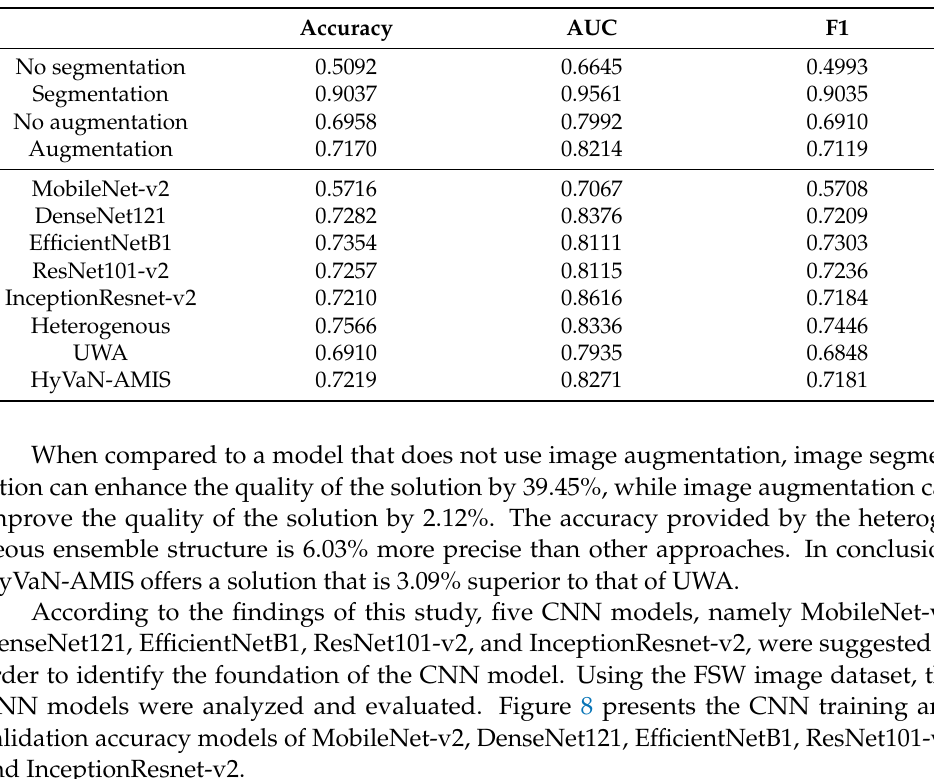
Table 7. The effects of the components contributing to the proposed